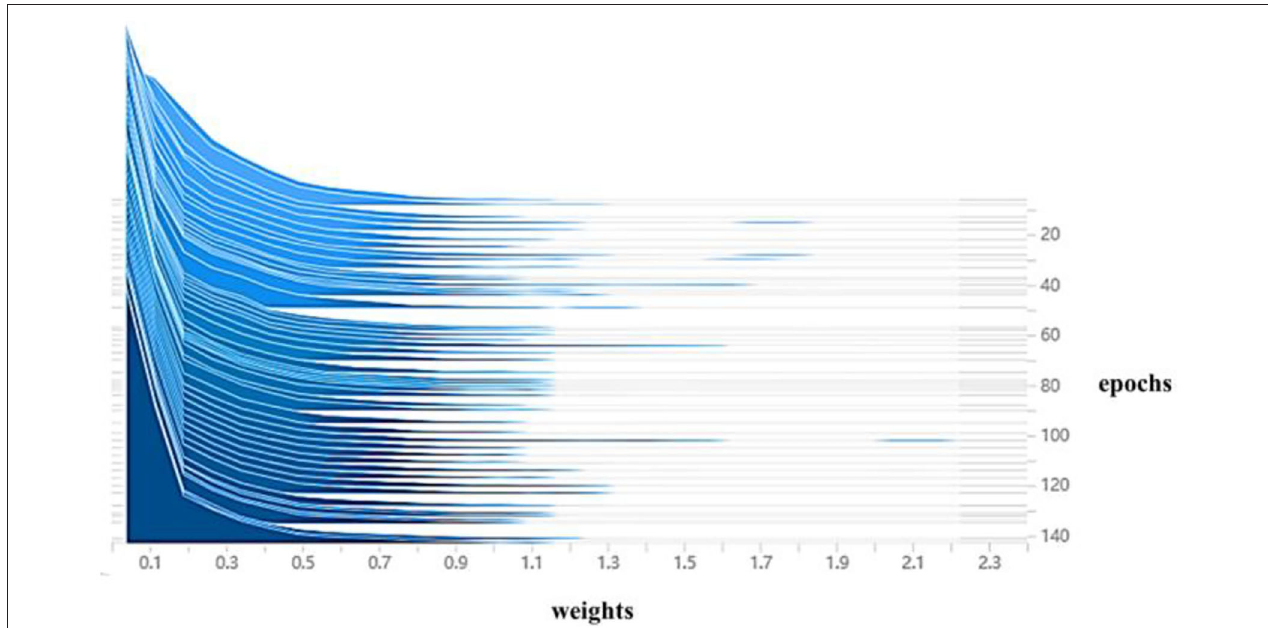
FIGURE 11 | Histogram of model weight change during sparse training.